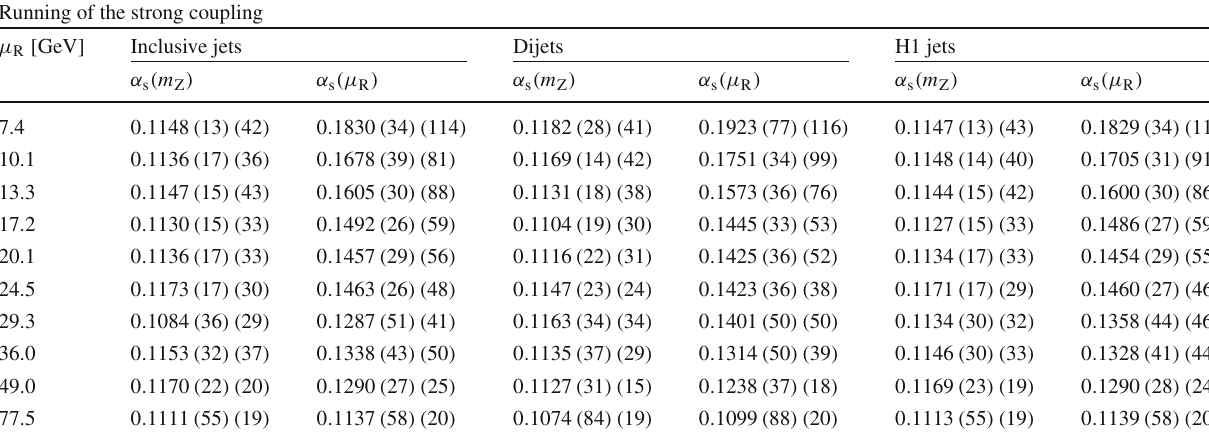
Table 5 Values of the strong coupling constant α s (μ R ) and at the Z - boson mass, α s ( m Z ) , obtained from fits to groups of data points with comparable values of μ R . The first (second) uncertainty of each point